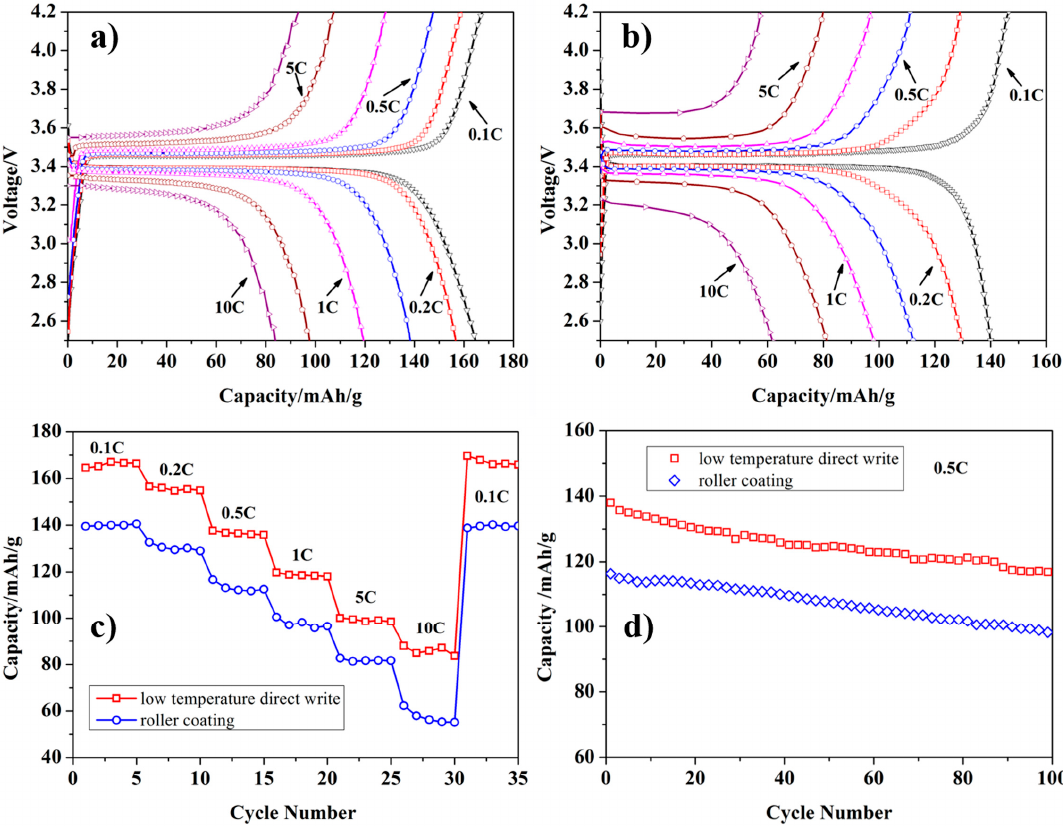
Figure 12. Electrochemical performance of LTDW-fabricated LiFePO4 electrodes and conventional roller-coated electrodes: ( a ) charge/discharge curves of LTDW-fabricated electrodes; ( b ) charge/discharge curves of roller-coated electrodes; ( c ) rate performance; ( d ) cycle